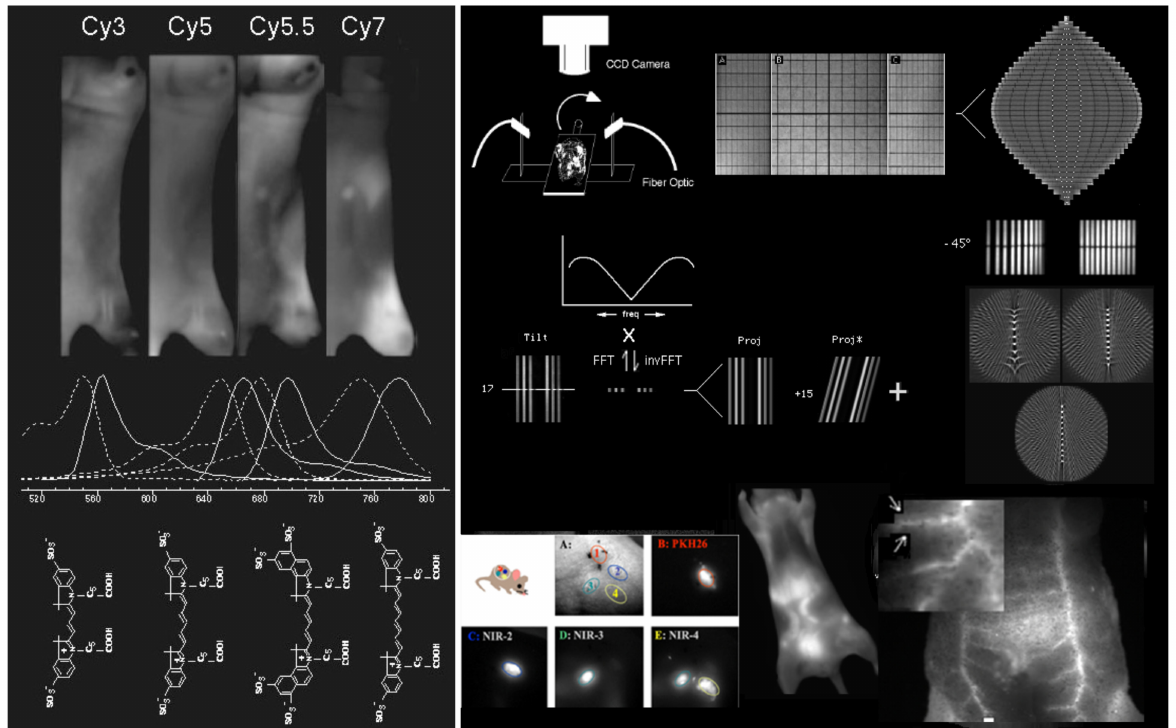
Figure 13. In vivo imaging of fluorescently targeted tumors: the importance of wavelength. Left: Tumors induced in a nude mouse were targeted with antibody, labeled with an equimolar mixture of Cy 3, Cy 5, Cy 5.5, and Cy 7. As the number of carbon atoms in the chains increases (bottom), so does the wavelength (excitation and emission) of the fluorophore (middle). Since the images (top) are of the same mouse, at the same time (but in different wavelength channels), one can see that the tumor (including a necrotic area) is better visualized the longer the wavelength. Cy 7 yields by far the best “transparency”, due to lowered scattering . Right: 3D imaging schematics illustrating our Digital Optical Goniometry (DOG) scans. Any features that can be highlighted in fluorescence (such as internal organs, blood vessels (shown), and targeted cancers can be mapped in 3D. Multiparameter fluorescence is also possible, as illustrated (insert, lower middle) with another family (PKH) of dyes [96] that can be wavelength-tuned (and we had access to several non-commercial